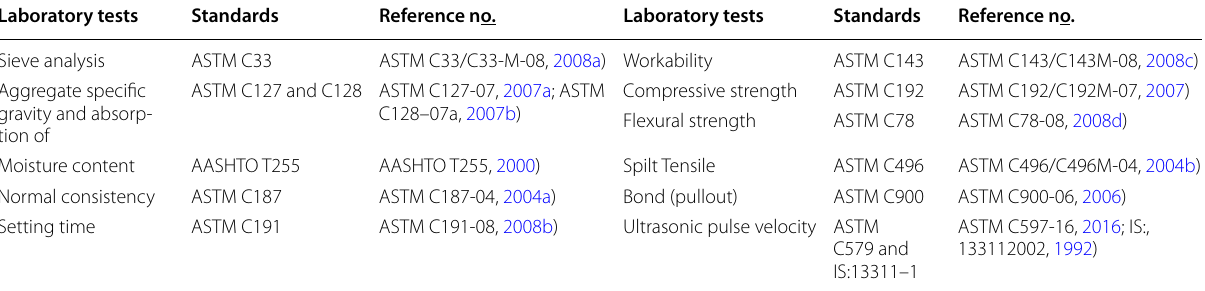
Table 4 Summary of laboratory tests conducted in this